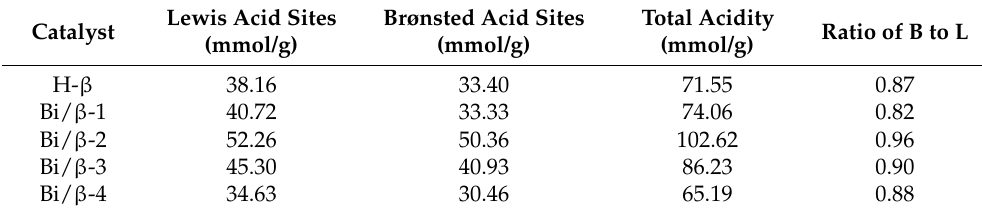
Figure 8. ( a ) Bi4f spectra of Bi/ β catalysts with different Bi loading, ( b ) O1s XPS spectra of Bi/ β -2.